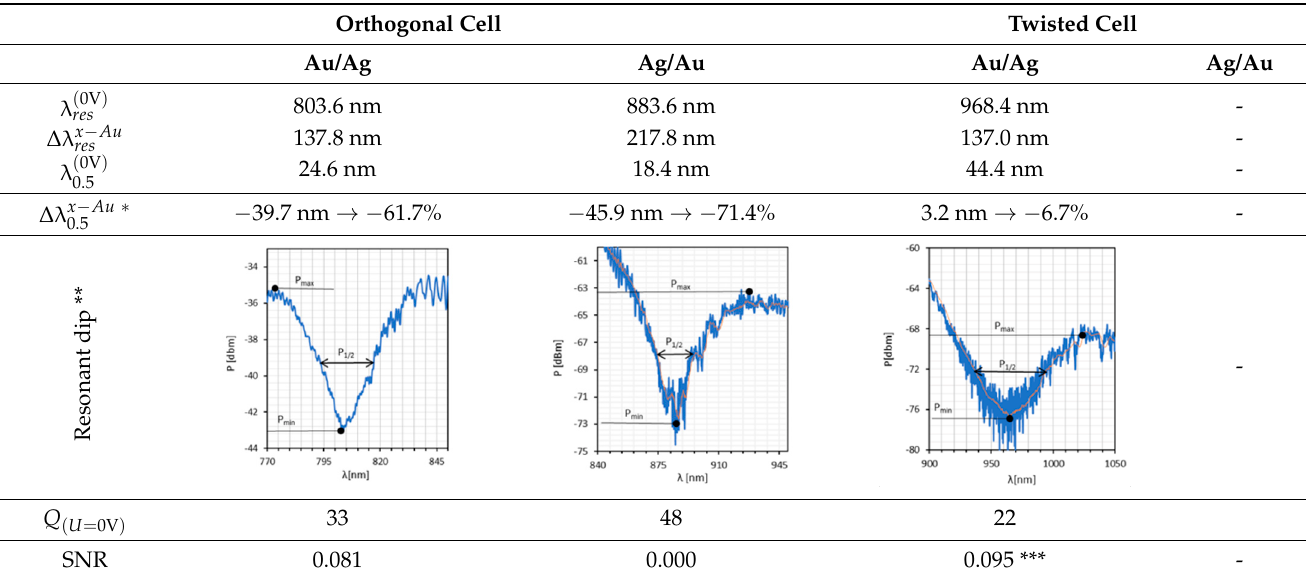
Table 2. Comparison of resonant dips of orthogonal and twisted cells compared to the dips obtained for cells with gold films.